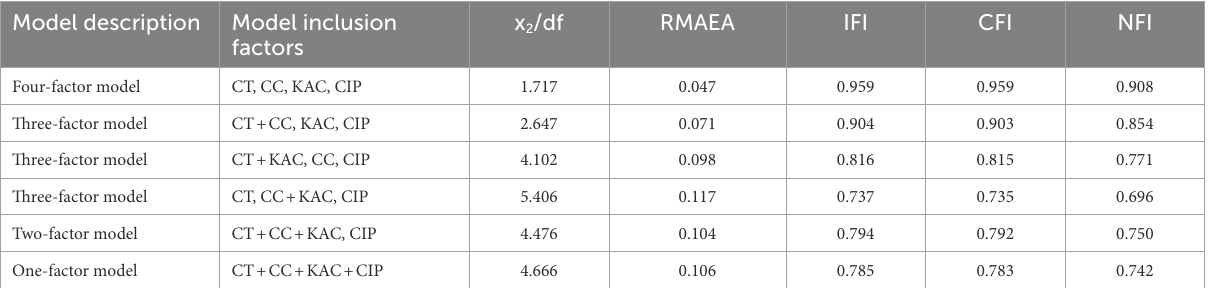
TABLE 3 Results of confirmatory factor analysis.